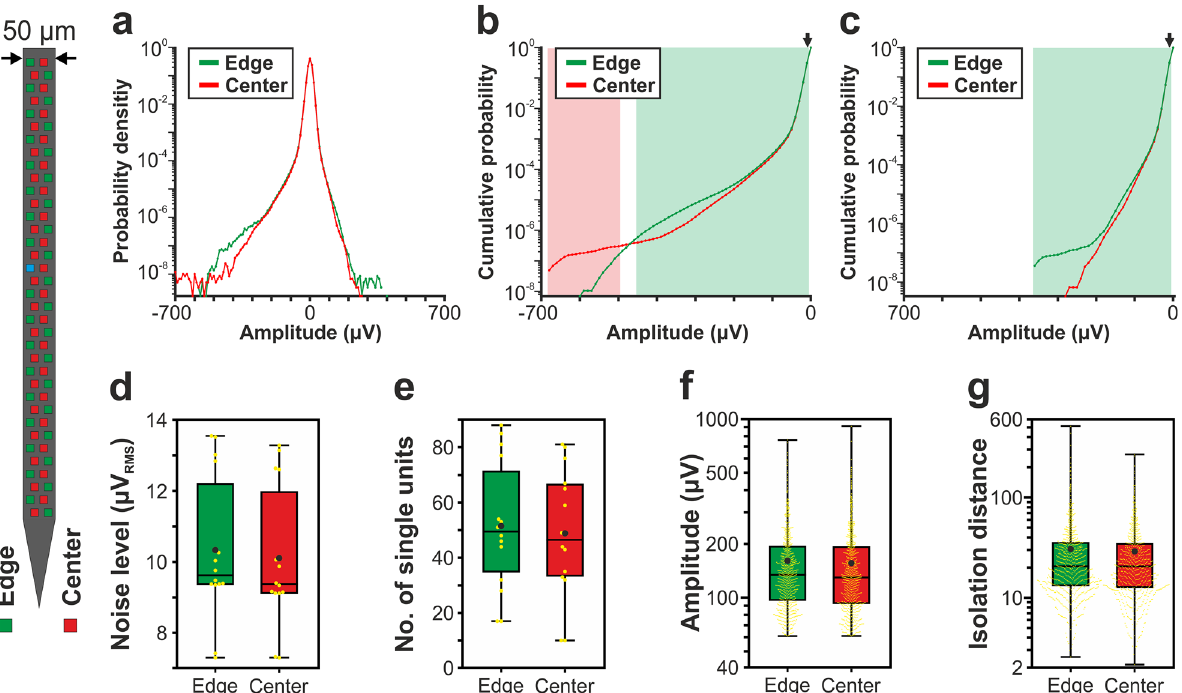
Figure 5. Comparison of the signal quality provided by edge (green) and center (red) sites of the 50-μm-wide Neuropixels silicon probe. ( a ) Probability density functions estimated from the amplitude of samples recorded in the 500–5000 Hz frequency range (n = 7 recordings). Probability values lower than 10 –9 are not shown. ( b ) Cumulative distributions of amplitudes calculated in the negative amplitude range. ( c ) Reverse cumulative distributions calculated in the positive amplitude range. Green (or red) shaded areas in ( b ) and ( c ) indicate amplitudes with significantly higher numbers of edge (or center) samples. Arrows mark the maximal amplitude for edge significance in the negative range (− 10 µV; below this amplitude 15.73% of all negative samples were recorded on edge sites and 15.57% on center sites) and the minimal amplitude in the positive range (10 µV; above this amplitude 15.20% of all positive samples were recorded on edge sites and 15.03% on center sites). ( d ) Estimated in vivo noise level. ( e ) Single unit yield (n = 1405). ( f ) Peak-to-peak amplitude of the averaged single unit spike waveforms. ( g ) Isolation distance of the single unit clusters. Note that most data are plotted on a logarithmic scale. Mann–Whitney U test was used in ( d – g